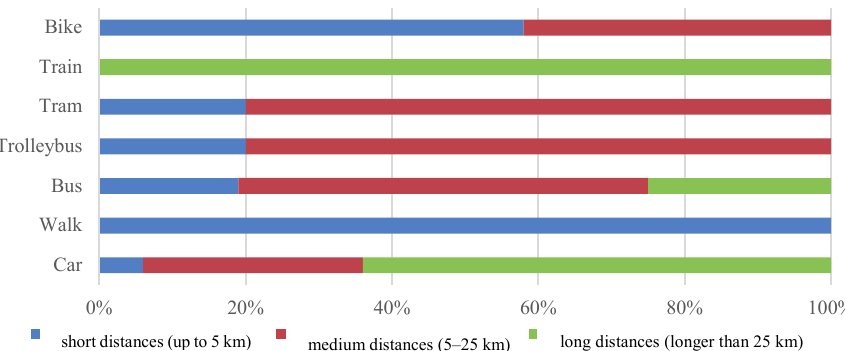
Fig. 4. Use of transport modes depending on the